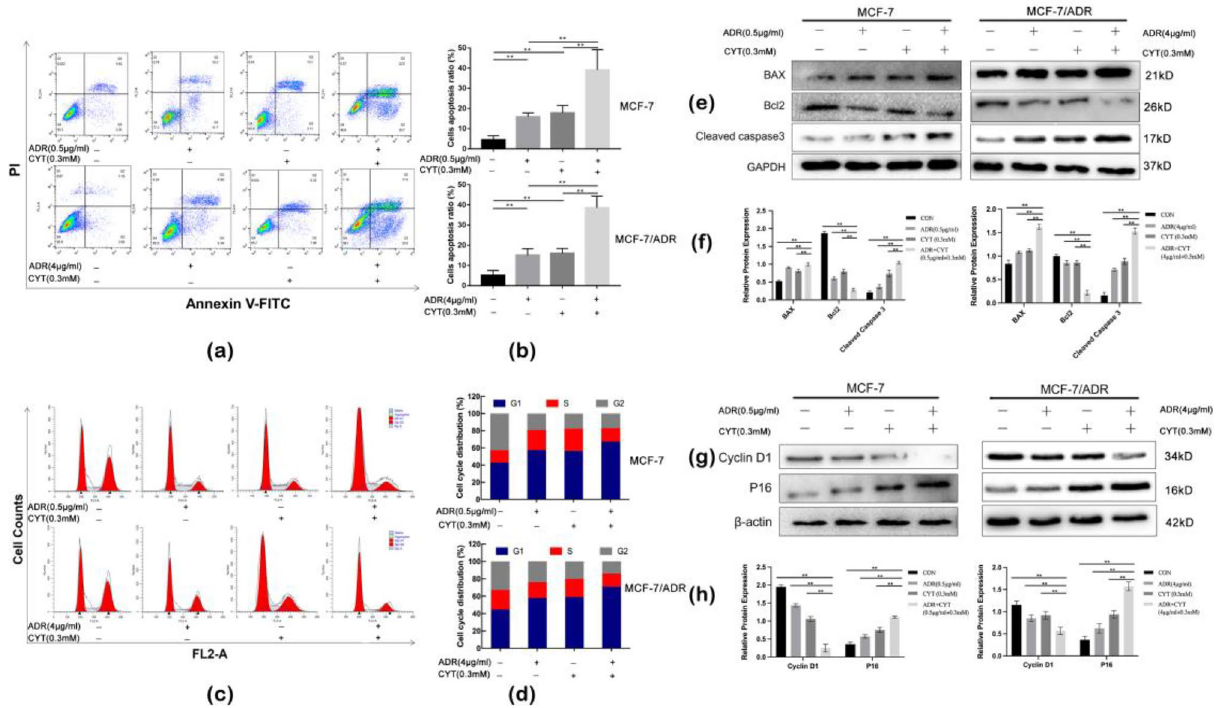
Figure 2. CYT combined with ADR intensified apoptosis and inhibited the cell cycle in the G0/G1 phase of MCF-7 and MCF-7/ADR cells. ( a,b ) Flow cytometry indicated that the apoptosis rate of the monotherapy group was higher than that of the control group in MCF-7 and MCF-7/ADR cells, the apoptosis rate of the ADR + CYT group was significantly higher than that of the monotherapy group. ( c,d ) Flow cytometry indicated that G0/G1 phases in the monotherapy group and the combined group were greater than that in the control group in MCF-7 and MCF-7/ADR cells. ( e ) The antiapoptotic protein Bcl-2 was lower in the combined group, but proapoptotic proteins, such as BAX and Cleaved-caspase3, were significantly increased. ( f ) The relative expression of the apoptotic proteins (Bcl-2/GAPDH, BAX/GAPDH, and Cleaved-caspase3/GAPDH) were quantified by ImageJ and analyzed by GraphPad Prism 9. ( g ) Western blot analysis to determine the expression of P16, Cyclin D1. β-actin was used as a loading control. ( h ) The relative expression of G0–G1 phase transition-related proteins Cyclin D1/β-actin and P16/β-actin) was quantified by ImageJ and analyzed by GraphPad Prism 9. The values are obtained from three independent experiments and represented as mean ± S.D. ** p <